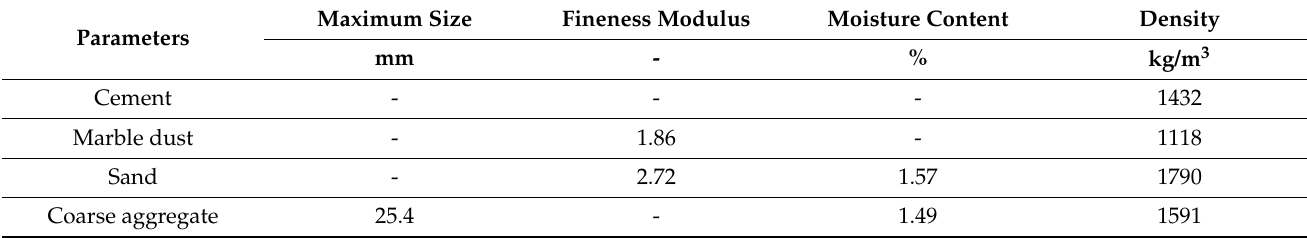
Table 2. Physical properties of raw materials.